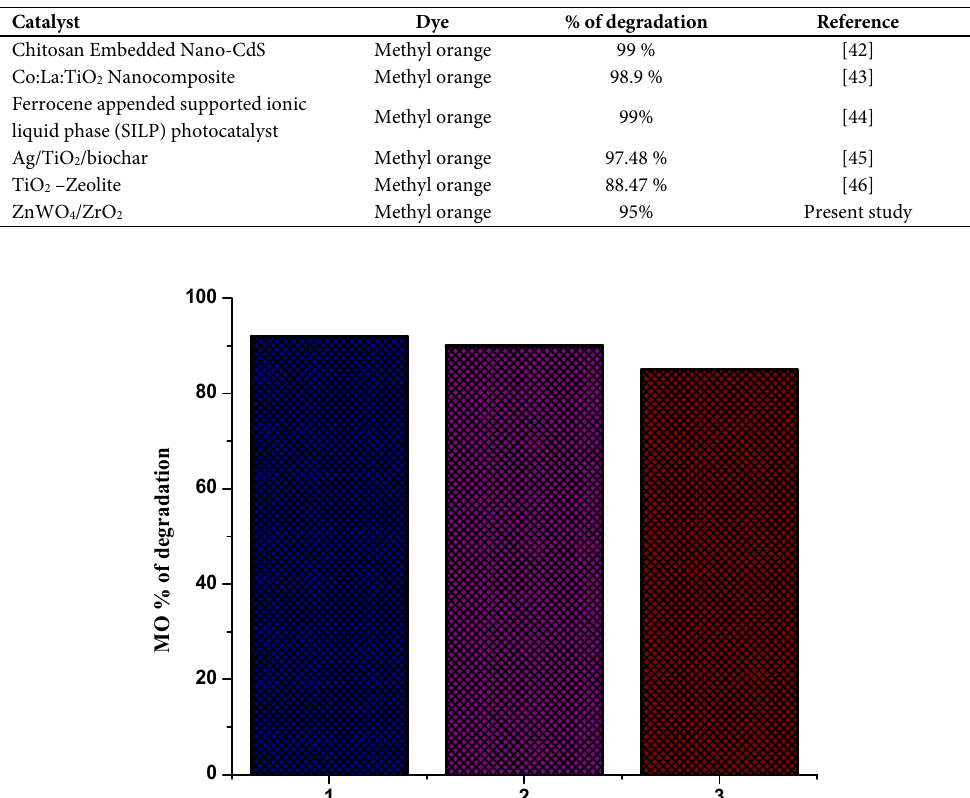
Table. 2 The comparison of methyl orange degradation efficiency for different